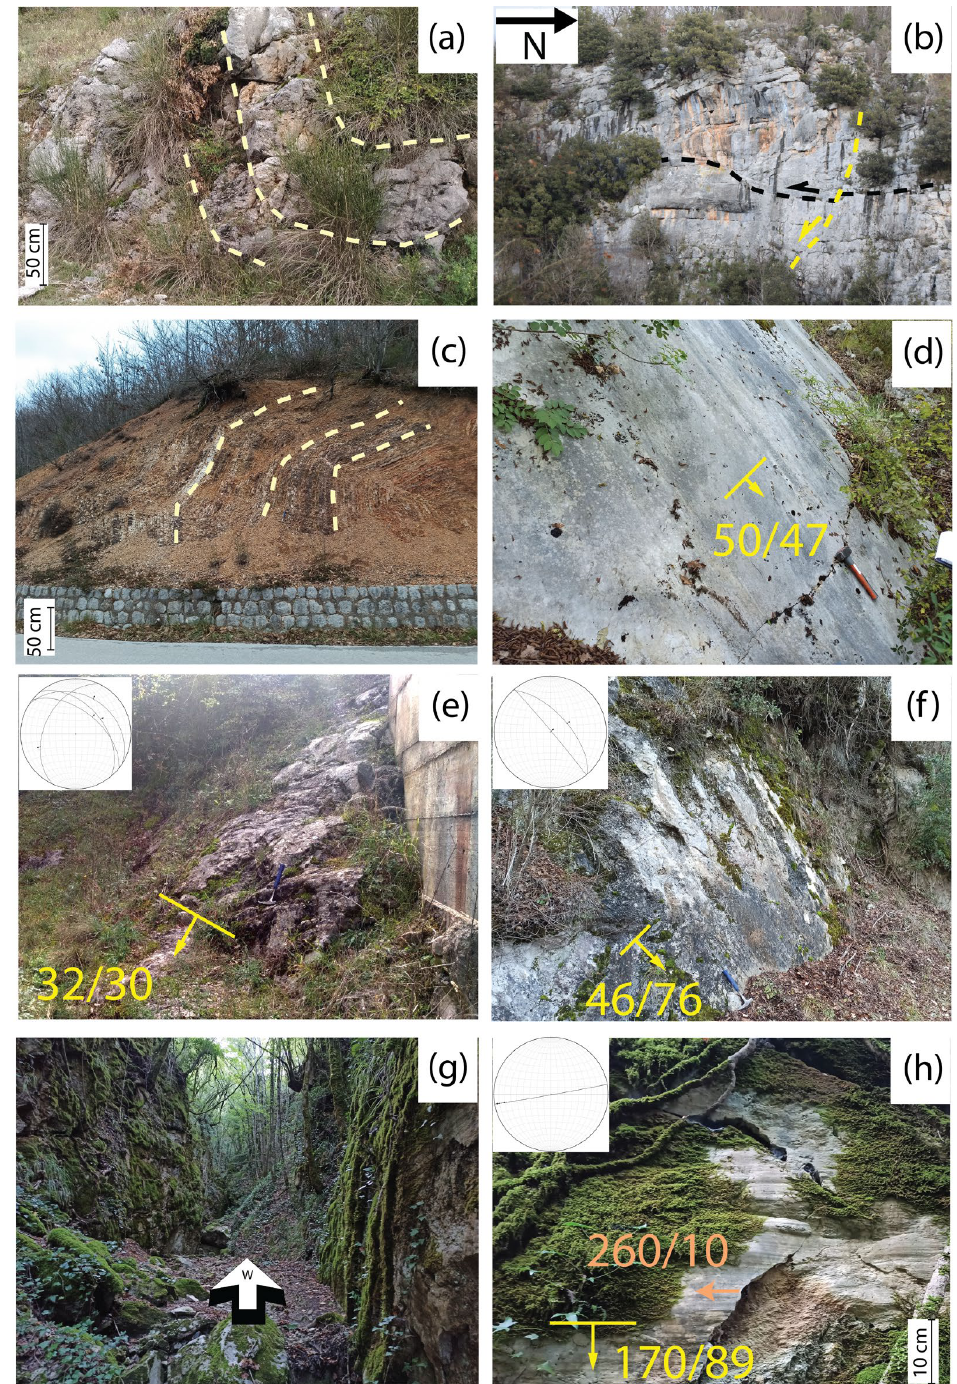
Figure 6. Examples of tectonic structures exposed in the study area: ( a ) folding affecting Jurassic limestone of the Apennine Platform, ( b ) thrust-related anticline in the carbonates of the Apennine Platform exposed along the left side of the Cavolo Gorge, ( c ) intense deformation in the Scisti Silicei Formation (Lagonegro II Unit), ( d ) an example of a medium-angle normal fault near the Fossatello Gorge, ( e ) a low-angle normal fault near the hydroelectric power plant, ( f ) a NW-trending normal fault in the right side of the Cavolo Gorge and ( g ) the Fossatello right-lateral strike-slip fault in the Fossatello Gorge. ( h ) Detail of the Fossatello fault, showing horizontal striations and grooves. The stereonets in ( e , f , h ) represent the orientations of the striae and fault planes in the areas represented in the photographs.